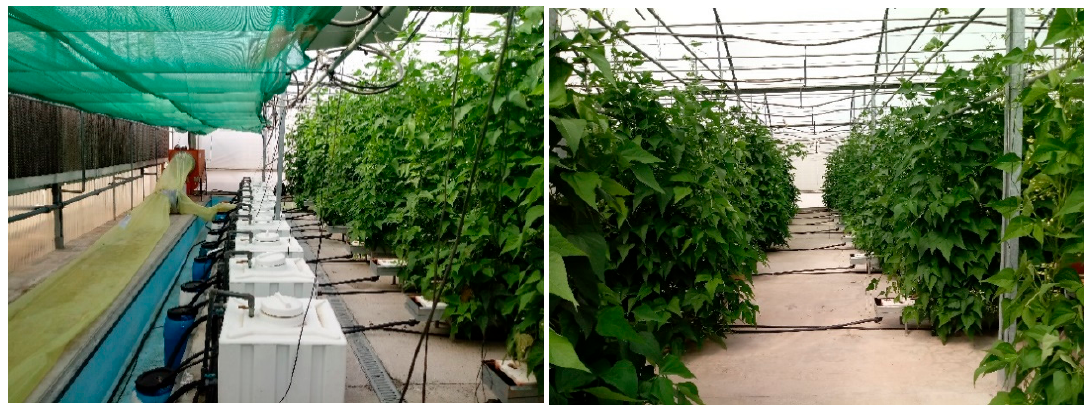
Figure 1. Common bean ( Phaseolus vulgaris L. cv. Moraleda) grown in nutrient film technique (NFT) hydroponic circuits, under Mediterranean greenhouse conditions.